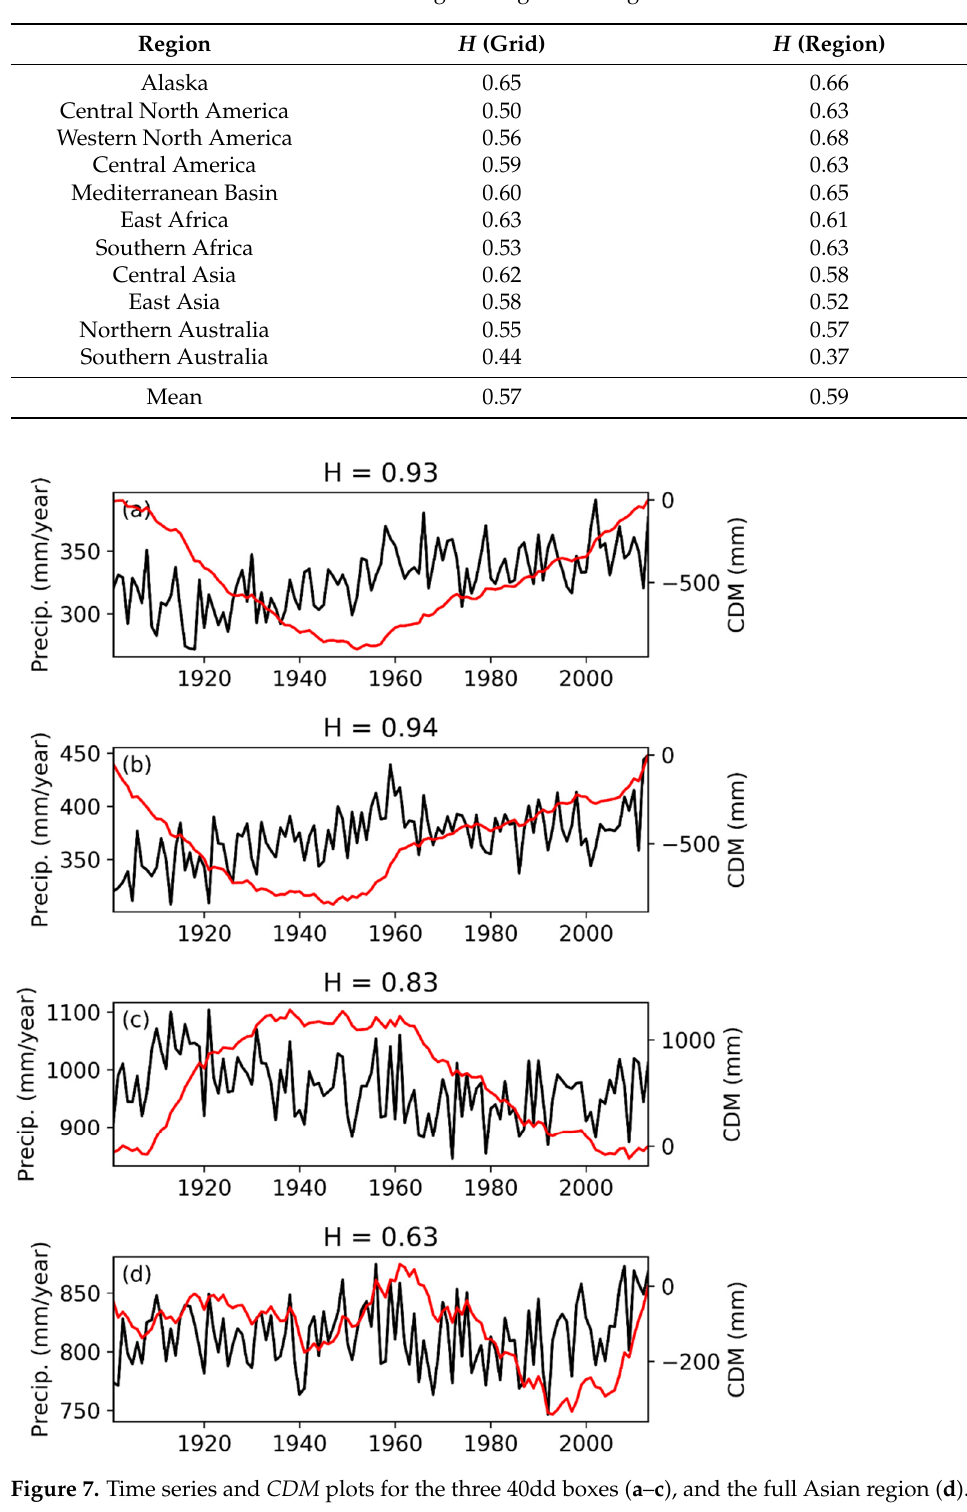
Table 1. H values for the eleven selected regions at grid and regional scales.